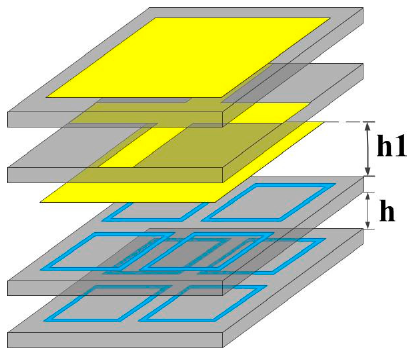
Figure 8. Multilayer patch-grid FSS integrating with HS-FSMSE (The yellow and blue parts represent metal, the grey represents substrates).